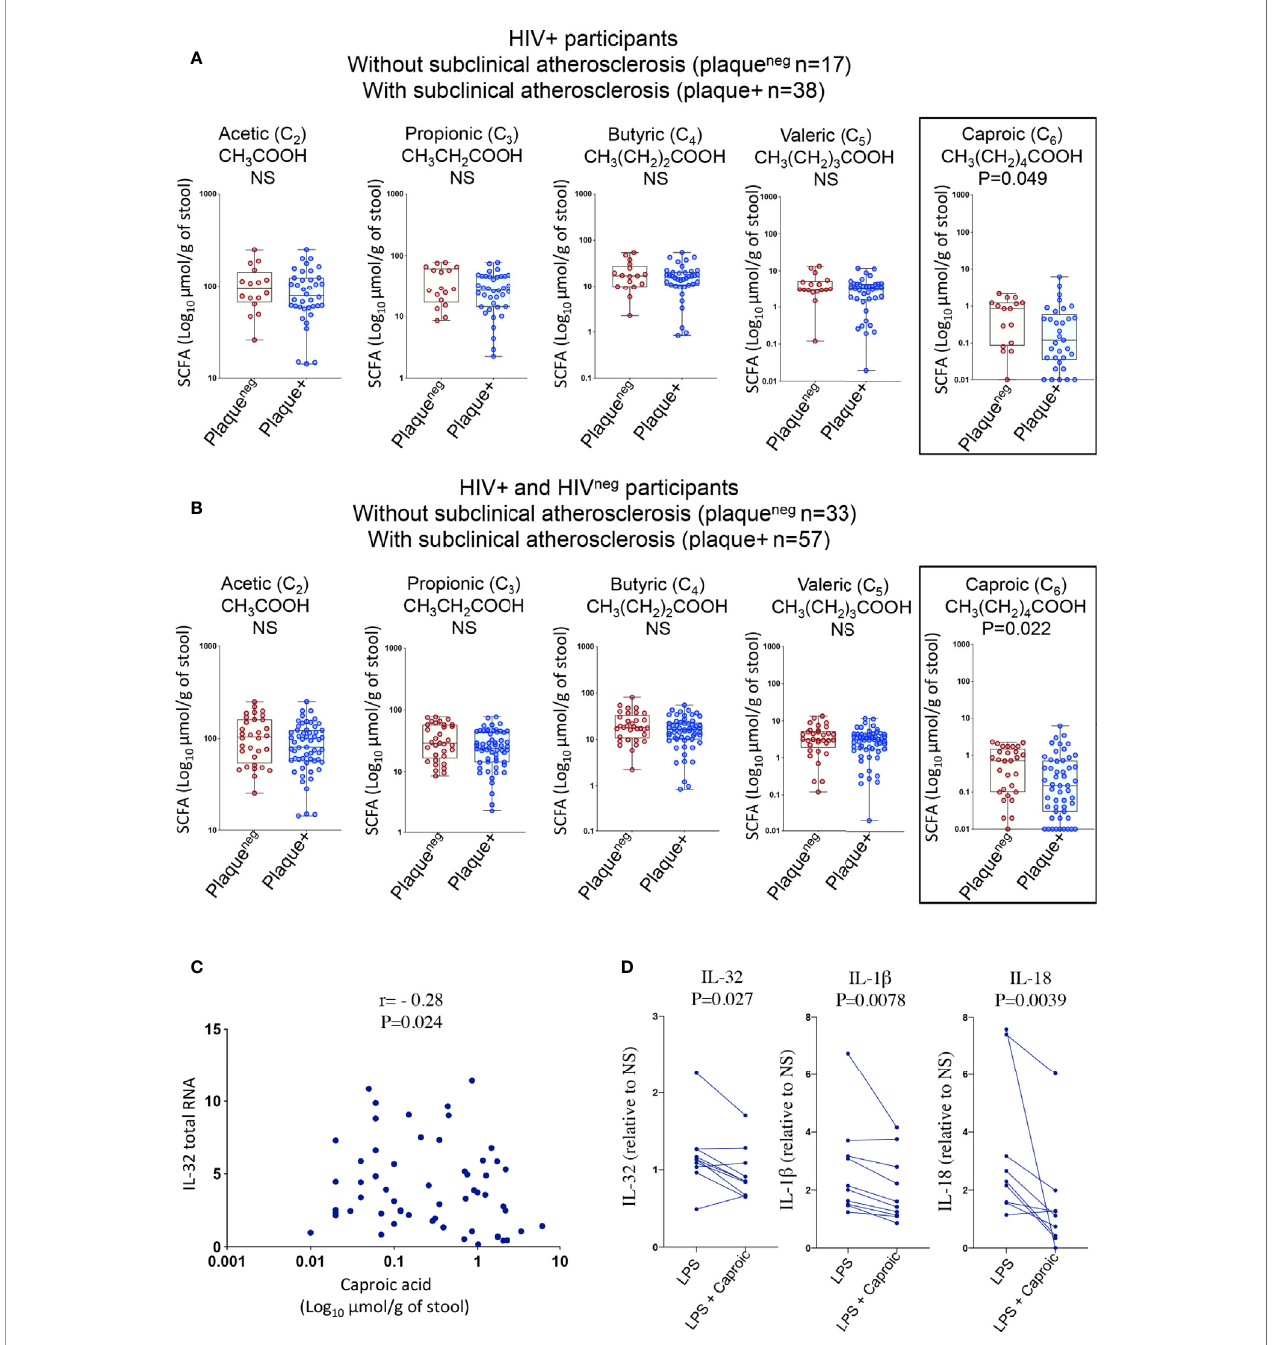
FIGURE 6 | Gut levels of short-chain fatty acids in HIV+ and HIV neg participants with or without subclinical atherosclerosis shown in Box-whiskers plot (min-max). (A) Levels of the individual short chain fatty acids measured in fecal samples collected from HIV+ individuals without (n=17 plaque neg ) compared to HIV+ participants with subclinical atherosclerosis (n=38 plaque+). (B) Levels of the individual short chain fatty acids measured in fecal samples collected from both HIV+ and HIV neg without (n=33 plaque neg ) compared to individuals with subclinical atherosclerosis (n=57 plaque+). All values are expressed in Log 10 m mol/g of fecal sample. (C) Correlation between levels of caproic acid in fecal samples and IL-32 total RNA in PBMCs (measured by RT-qPCR and normalized to the housekeeping gene b - glucuronidase) from HIV+ and HIV neg participants (n=63). (D) Impact of caproic acid pre-treatment (2mM for 2 hours) on production of in fl ammatory cytokines IL-32, IL-1 b and IL-18 in PBMCs stimulated with LPS (n=10). Cytokines measured by ELISA in supernatants of stimulated cells following 48 hours of stimulation (IL-18 and IL-1 b ) or in total cell lysate (for cell-associated IL-32 protein). Data are expressed as a fold change in cytokine expression in LPS-stimulated PBMCs, conditioned or not with caproic acid, relative to non-stimulated cells (NS). Data analyzed with the non-parametric Mann-Whitney in A, B Spearman correlation in C and Wilcoxon matched-pairs rank test in D . NS, non-signi fi